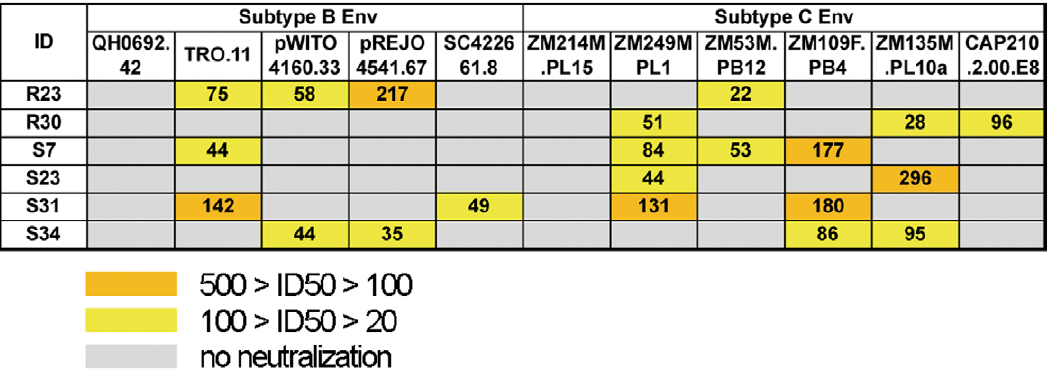
Figure 4. Anti-HIV-1 neutralizing activity of 6 selected plasma samples against B-Env- and C-Env-recombinant viruses. Neutralizing activity of 6 plasma samples against 5 B-Env- and 6 C-Env-recombinant viruses was evaluated as described in the legend to Figure 1. Data are presented as the means of at least three independent experiments. Plasma IDs and Env-recombinant viruses tested are denoted on the left side and above the panel, respectively. ID50 values 100–500 and 20–100 are highlighted in orange and yellow, respectively. No neutralization (ID50 values , 20) of a recombinant virus is denoted by a gray background.